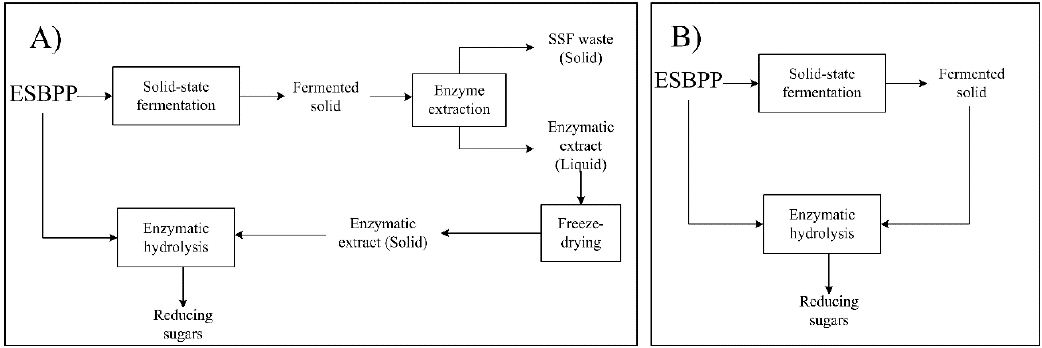
Figure 1. Schemes of the enzymatic hydrolysis of exhausted sugar beet pulp pellets (ESBPPs) by crude enzyme extracts obtained by solid ‐ state fermentation (SSF) ( A ) and by the addition of fermented solid ( B